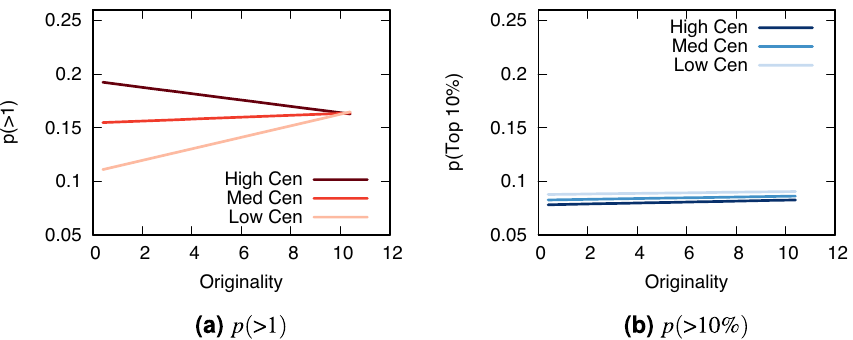
Figure 1. The interaction effect between originality and centrality. Originality on the x axis, centrality (“Cen” in the legend) is the darkness of the line, success on the y axis. ( a ) Probability of getting at least one upvote ( p (> 1 ) ) in red; ( b ) probability of being in the top 10% scoring posts in a day ( p (> 10% ) ) in